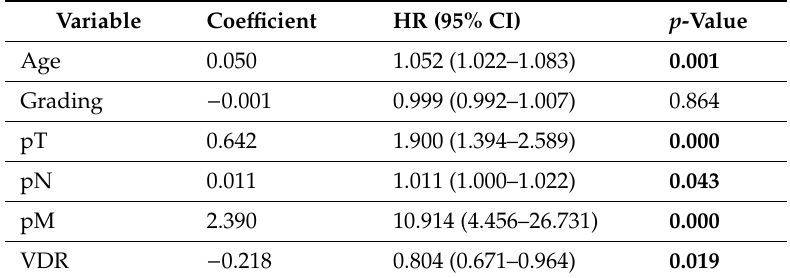
Table 8. Multivariate Cox regression analysis of multifocal BC patients regarding